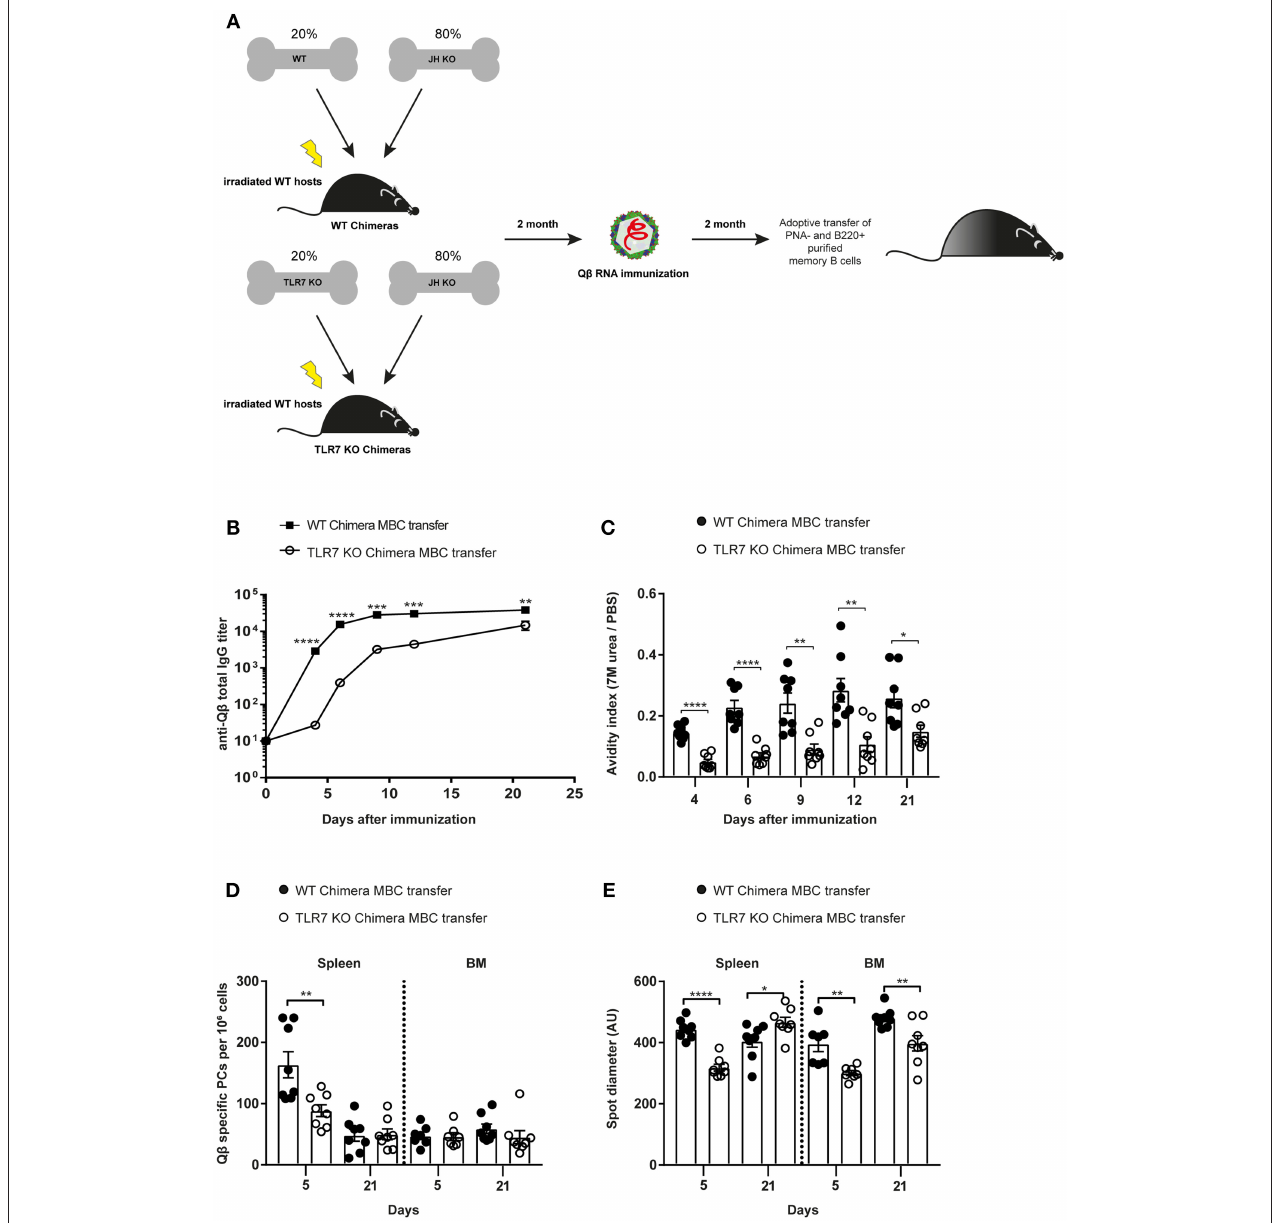
FIGURE 4 | B cell intrinsic TLR7 signaling is needed to generate memory B cells capable of producing secondary PCs. (A) Mixed BM chimeric mice with 20% WT or TLR7 KO and 80% JH KO BM were generated. Eight weeks after reconstitution the WT and TLR7 KO chimeras were immunized with 50 µ g Q β -RNA. Memory B cells from BM chimeric mice were transferred into congenic Ly5.1 recipients after 8 weeks. Recipient mice were challenged with 50 µ g Q β -RNA 24h after the adoptive transfer. (B) The anti-Q β total IgG titer in the serum after WT chimera (black squares) or TLR7 KO chimera (open circles) memory B cell transfer was determined by ELISA. (C) The avidity index of antibodies from sera generated after WT chimera (black circles) or TLR7 KO chimera (open circles) memory B cell transfer and challenge was calculated after performing a modified ELISA. ELSIPOT assays of splenocytes and BM cells were performed to determine PC number (D) and spot diameter (E) 5 and 21 days after WT chimera (black circles) or TLR7 KO chimera (open circles) transfer and challenge. Mean with SEM. P -values were obtained using an unpaired t -test. * p < 0.05, ** p < 0.01, *** p < 0.001, **** p < 0.0001. n = 4 mice per group. Data representative of two independent